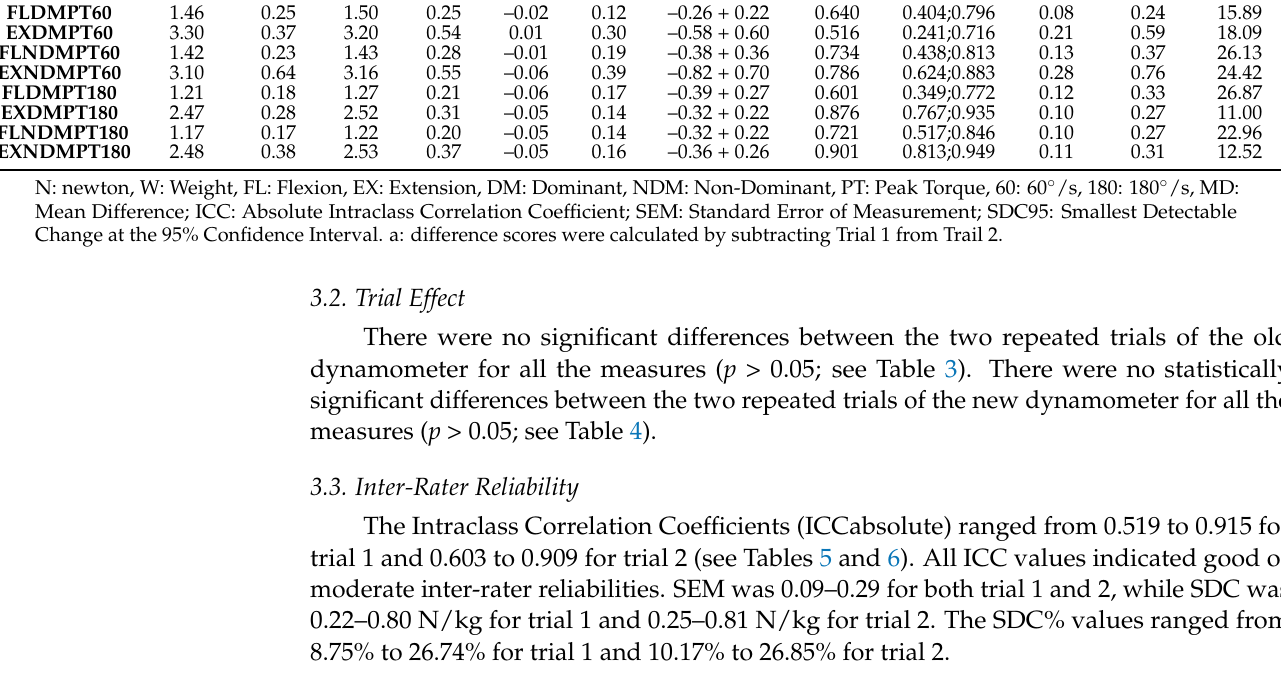
Table 5. Inter-rater reliability of trial